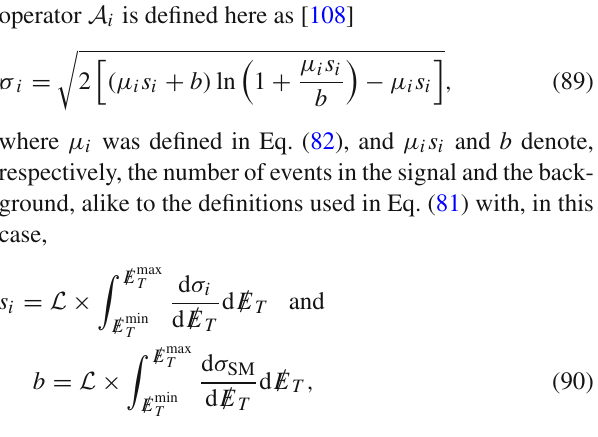
Table 6 Optimal missing transverse energy cut / E min T , and ( f a / c i ) max 2 (cid:2) σ projected sensitivity reach for aW γ production, for and integrated luminosities 300fb − 1 and 3000fb − 1 Luminosity [fb − 1